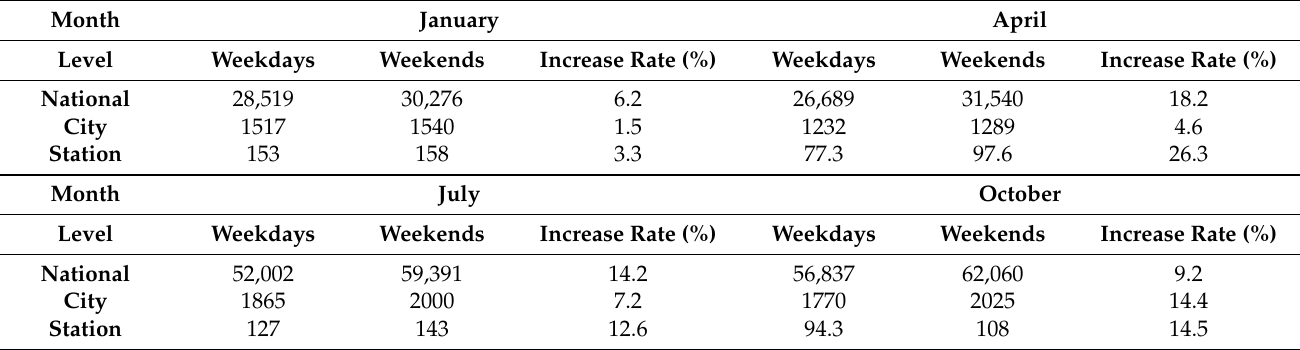
Table 2. Comparisons for charging amount by weekdays and weekends at three geographical